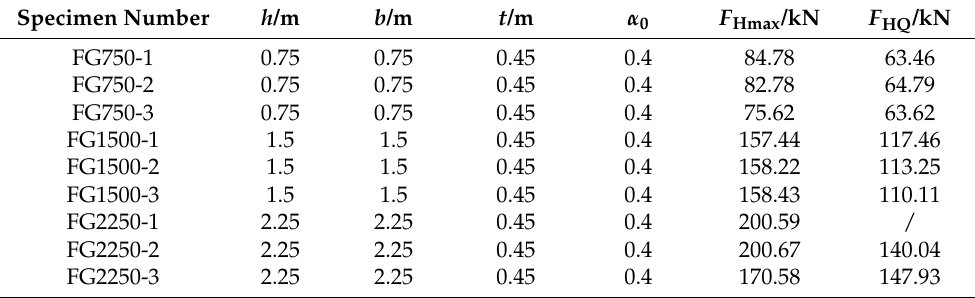
Table 4. Test data reported in reference [2].